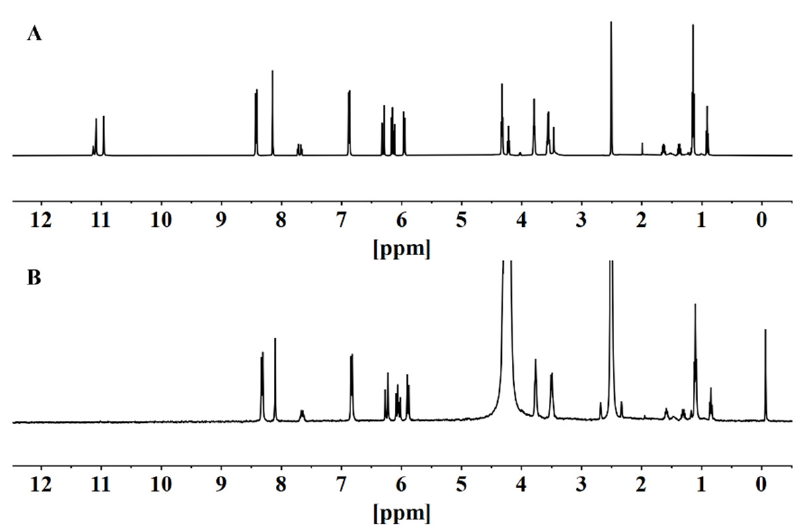
Figure 3. 1 H NMR Spectra of BNEA was measured in ( A ) DMSO-d6 and ( B ) mixed solvent (V DMSO-d6 :V D2O = 1:1).